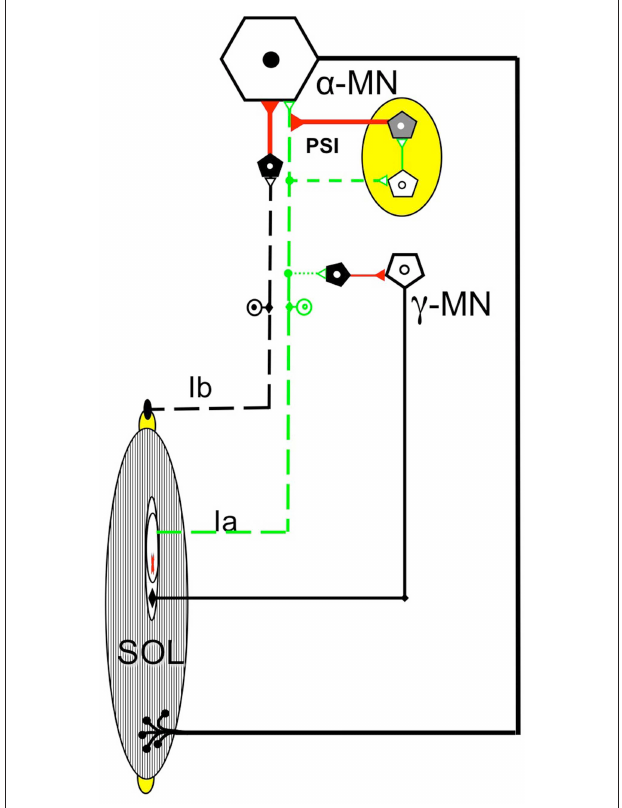
FIGURE 4 | The diagram shows the spinal circuitry that was possible involved γ -motor neurons ( γ -MN), α -motor neurons ( α -MN), Ia afferents (Ia), Ib afferents (Ib), or presynaptic mechanism (PSI), by near-muscle magnetic nerve stimulation. However, at this time, no conclusions can be reached about the mode of action of the magnetic stimulation on the spinal neuronal